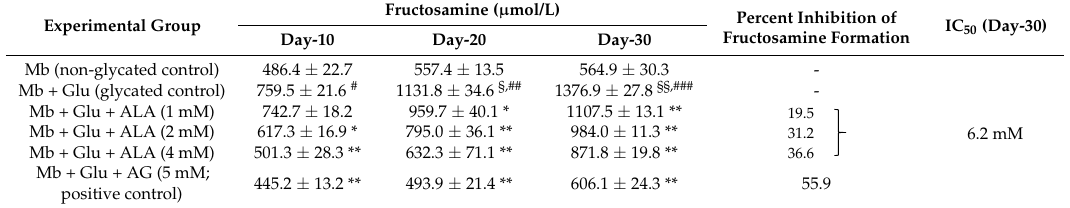
Table 2. Effect of α -lipoic acid on fructosamine formation in glucose-induced myoglobin glycation. Experimental Group